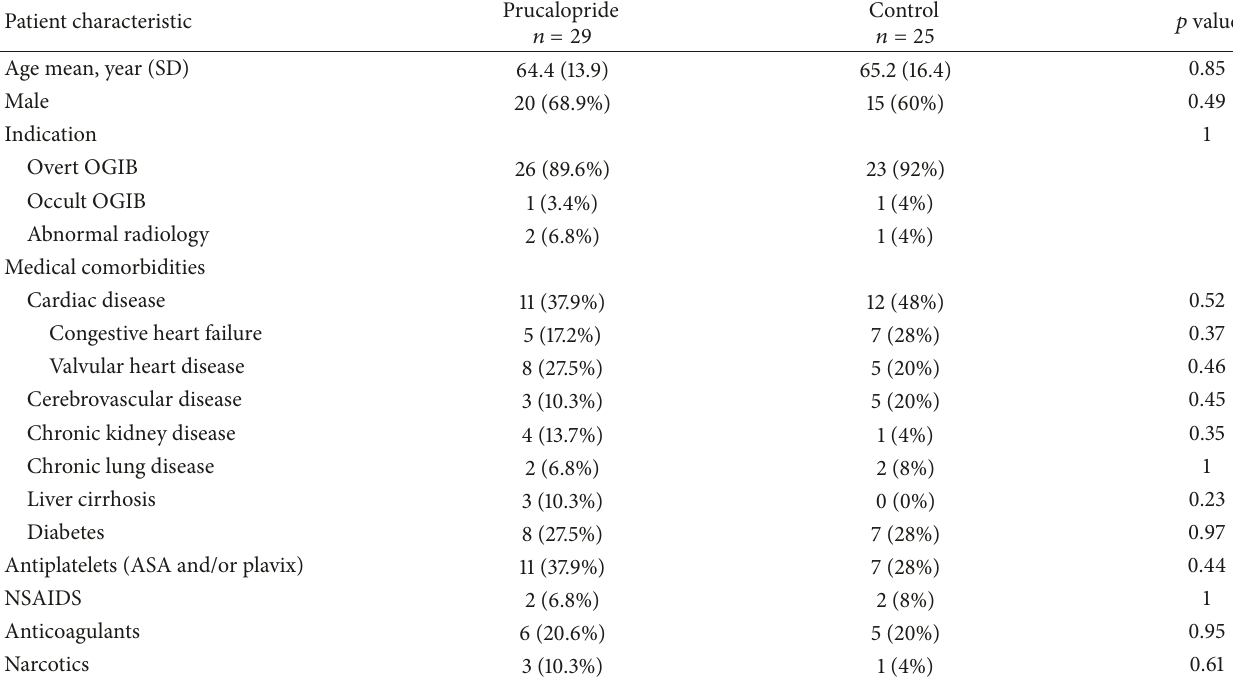
Table 1: Baseline characteristics of study population, the prucalopride versus the control group.